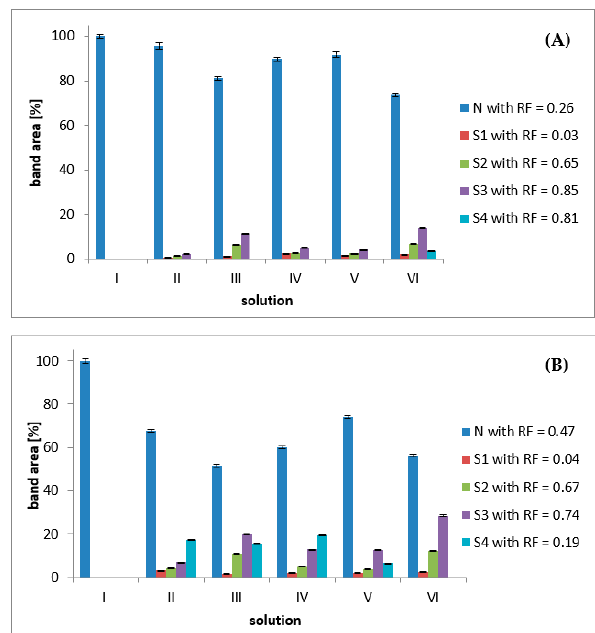
Figure 3. The comparison of peak areas (in %) of naproxen (N), which was irradiated to UV light (254 nm) from above in solutions II, III, IV, V, VI for 5 h. Substances (S1–S4) being the main products of its degradations and the standard of naproxen (I) (mobile phase: TOL-ACE-CHL (2:5:12, v / v / v) ( A ) and AcOH-Hex-ACE (0.10:10:10, v / v / v) ( B )), where S2—naproxen ethyl ester; S1, S3, S4—unknown degradation products of chemical transformation of naproxen.